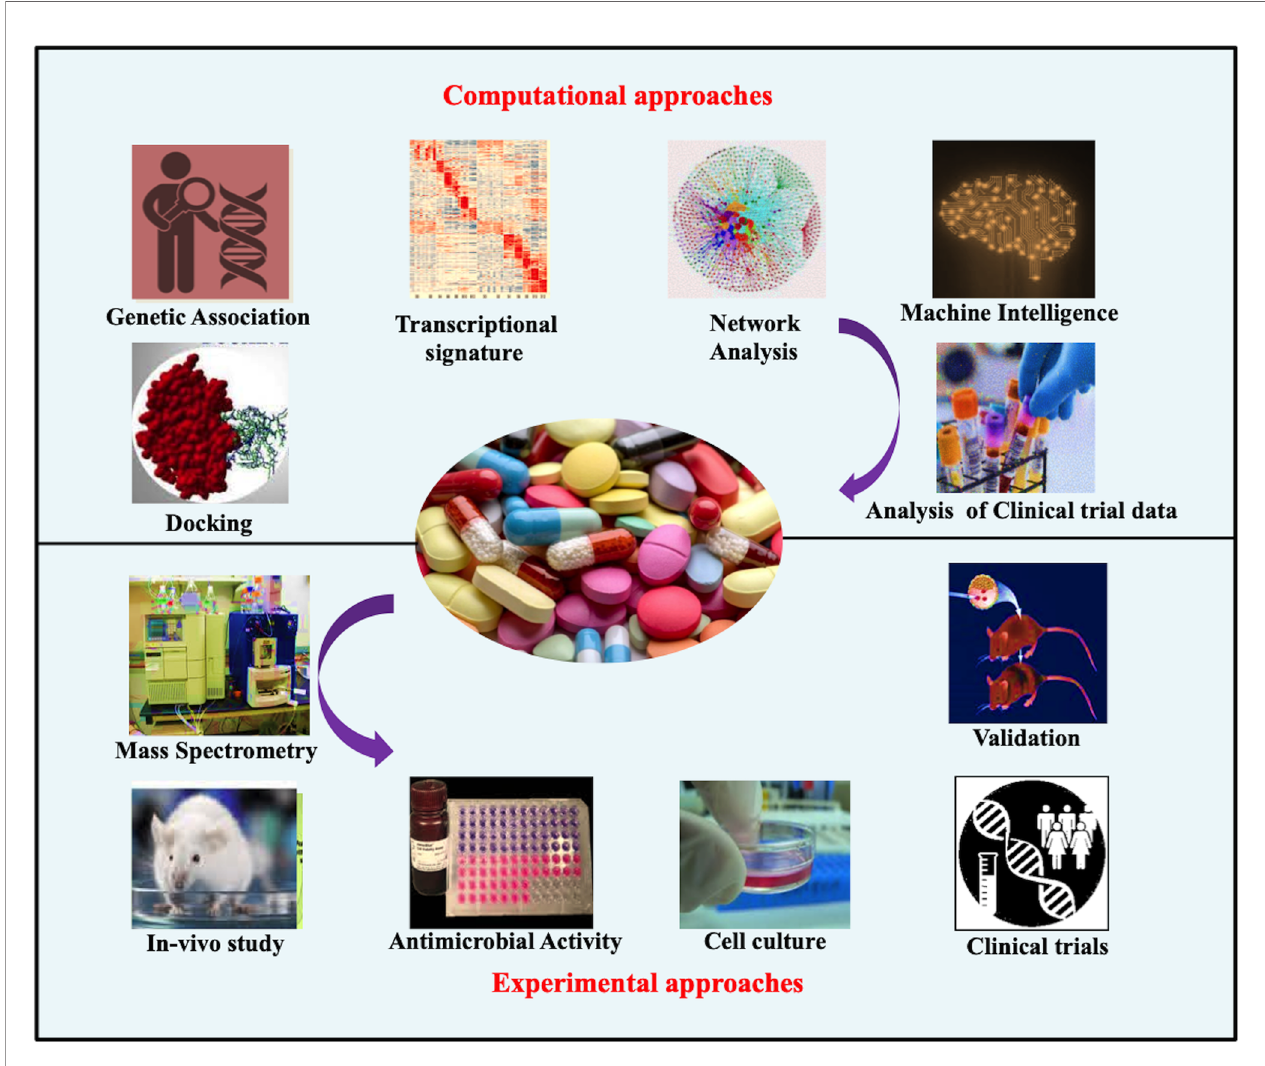
FIGURE 3 | Different computational and experimental approaches used in drug